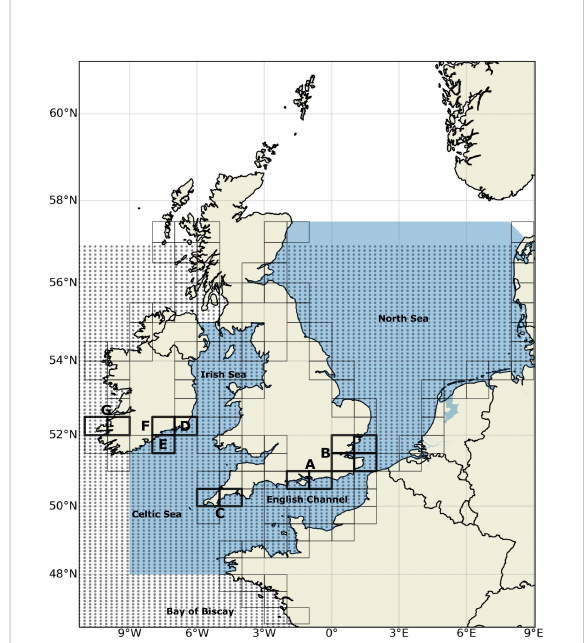
FIGURE 1 Model domain used for analysis. Grey dots indicate all potential spawning locations where eggs were released. Blue shading shows the northern sea bass stock region, comprising ICES Areas 4b-c and 7a, d-h. Coastal ICES rectangles (1° x 0.5° subdivisions of ICES areas; thin black lines) used to assess supply to nursey grounds, with relevant estuaries used for model comparison (thick black lines): (A) Solent; (B) Thames; (C) Fal and Helford; (D) Slaney; (E) Munster Blackwater; (F) New Ross Port; (G)